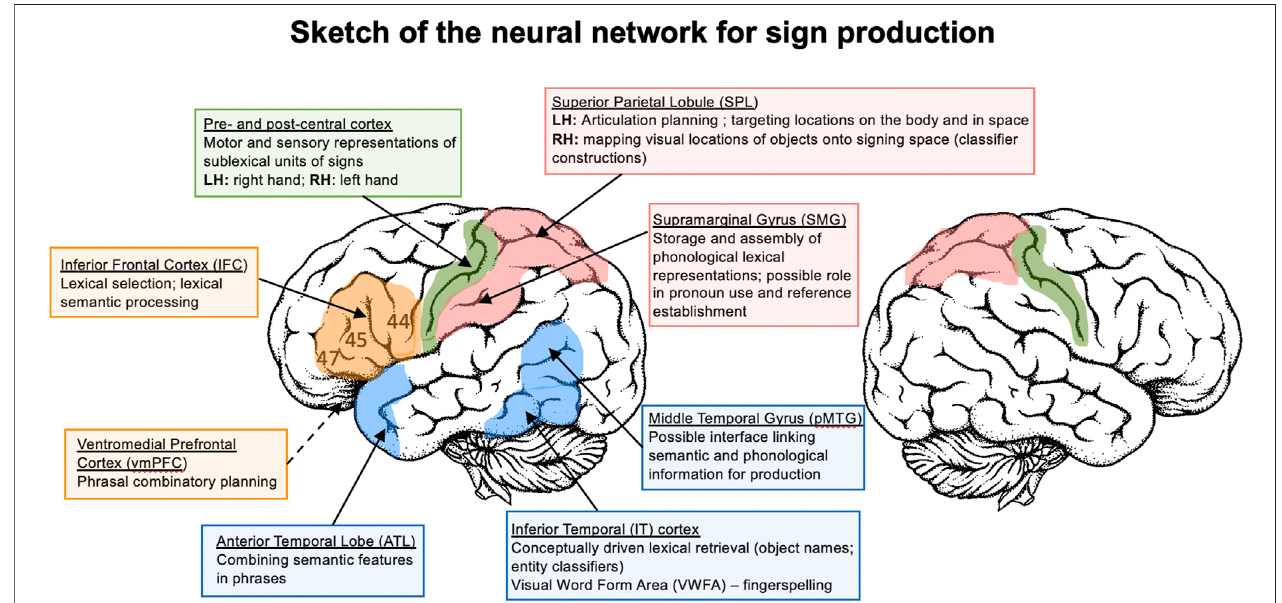
FIGURE 1 | A sketch of the neural network that supports the production of sign language. LH (cid:1) left hemisphere; RH (cid:1) right hemisphere.